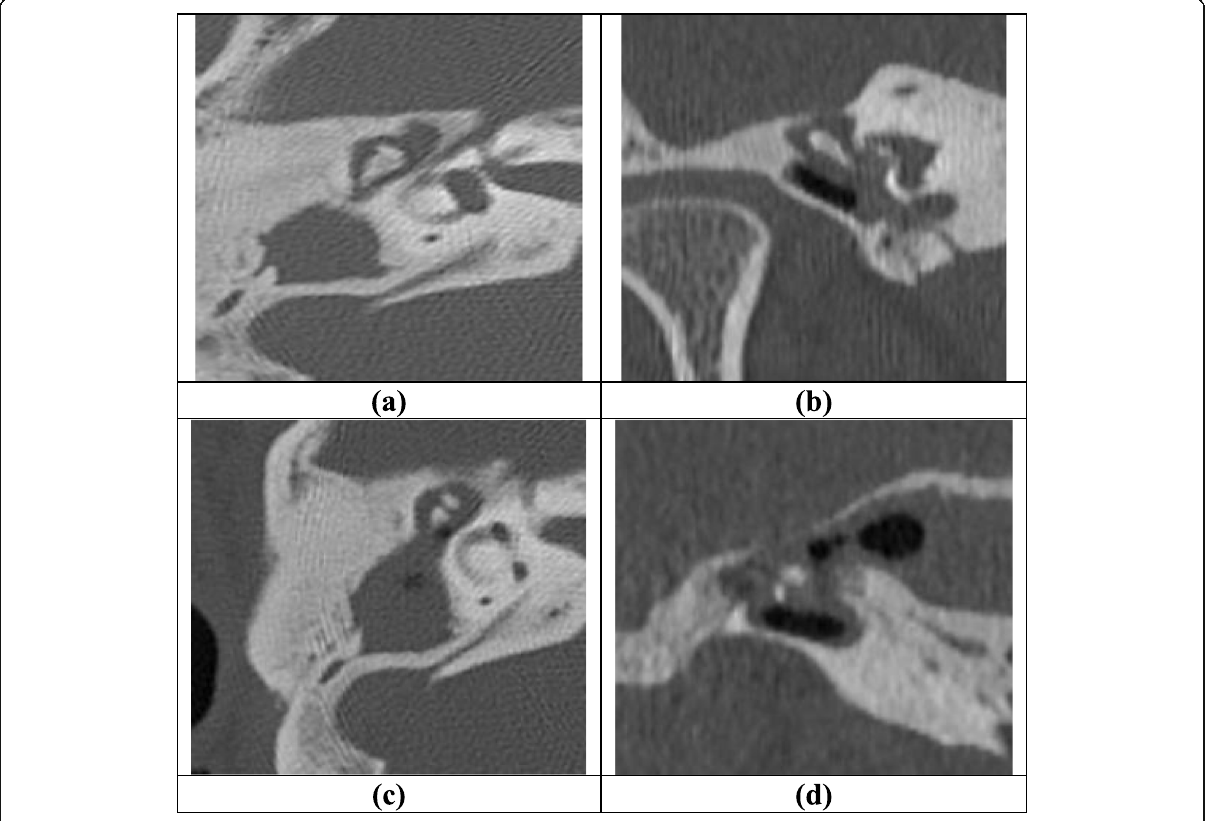
Fig. 5 Case 2 A 25-year-old male presented with proven cholesteatomatous CSOM. a Type-II (pyramidal type) is seen as a pyramidal projection at the lateral margin of the attic. The curved multi-planar image in b shows erosion of the lenticular process of the incus. Image c shows the mass effect on the attic and mild aditus widening. Köerner ’ s septum is not visualized. d Marked tegmental